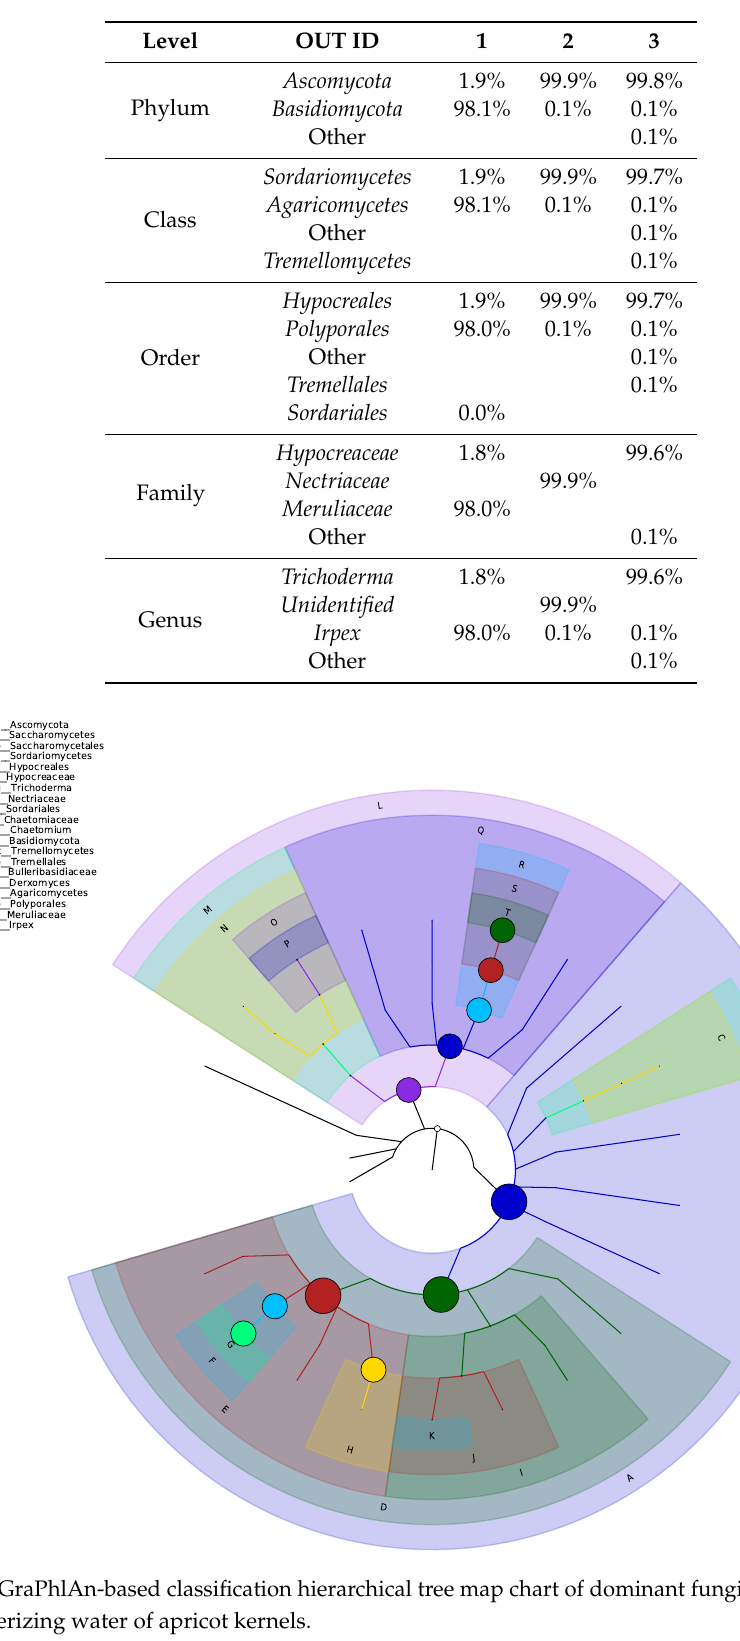
Table 3. Distribution of dominant fungi communities at di ff erent levels in the debitterizing water of apricot kernels.